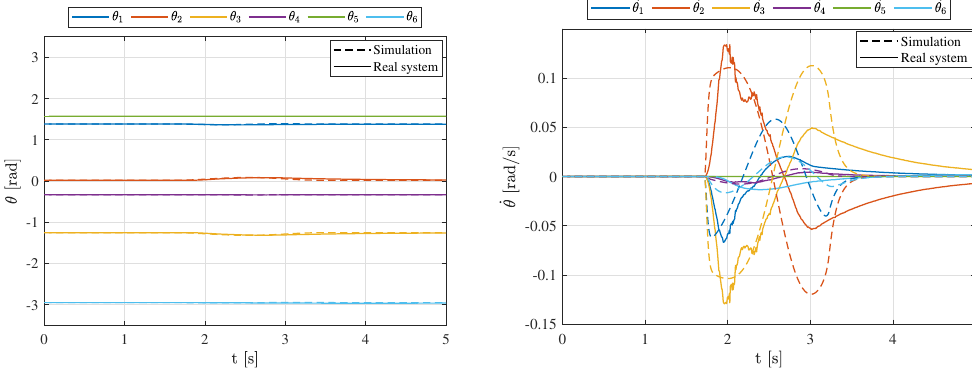
Figure 16. Test case 3, Mode II. Joint rotations ( left ) and speeds ( right ).